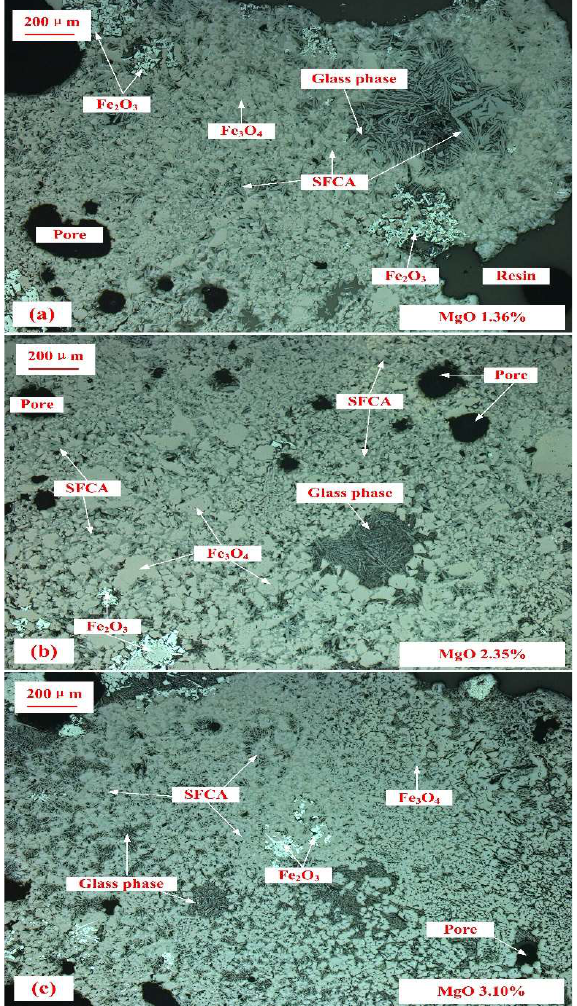
Figure 7. Microstructure of sinter with different MgO content (basicity 1.8), ( a ) MgO 1.36%, ( b ) MgO 2.35%, ( c ) MgO 3.1%. 2.35%, ( c ) MgO